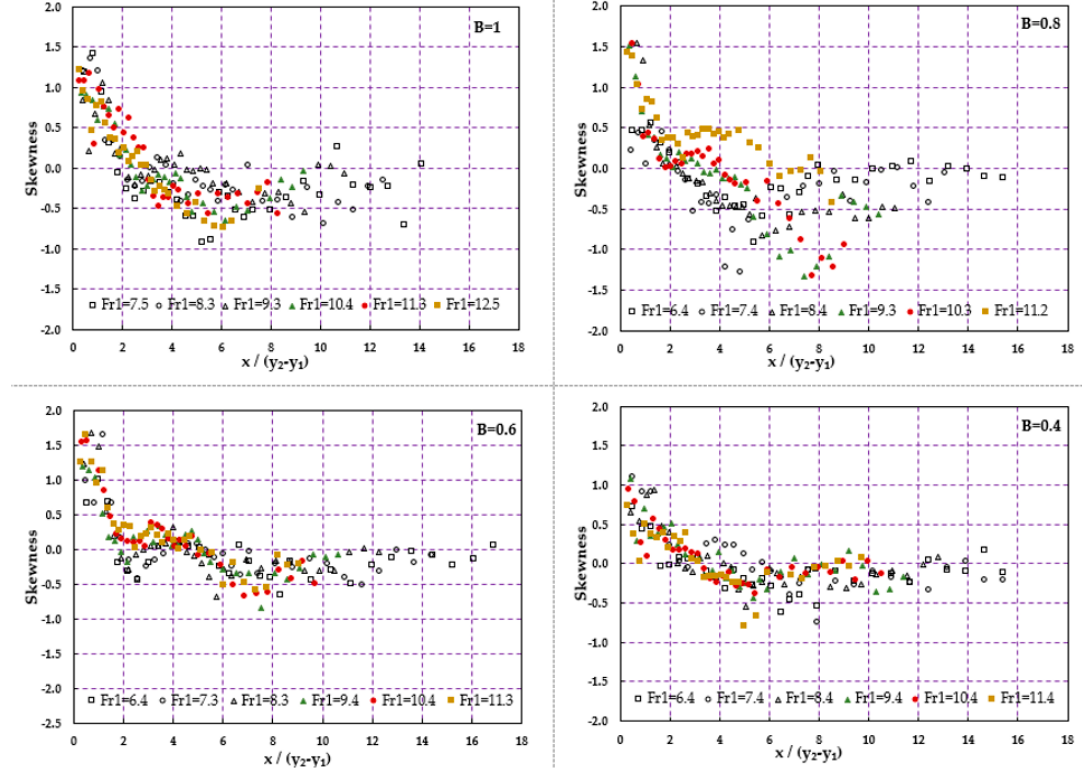
Figure 7. Distribution of the skewness coefficients versus relative distance from the toe of the hydraulic jump according to expansion ratio and Froude